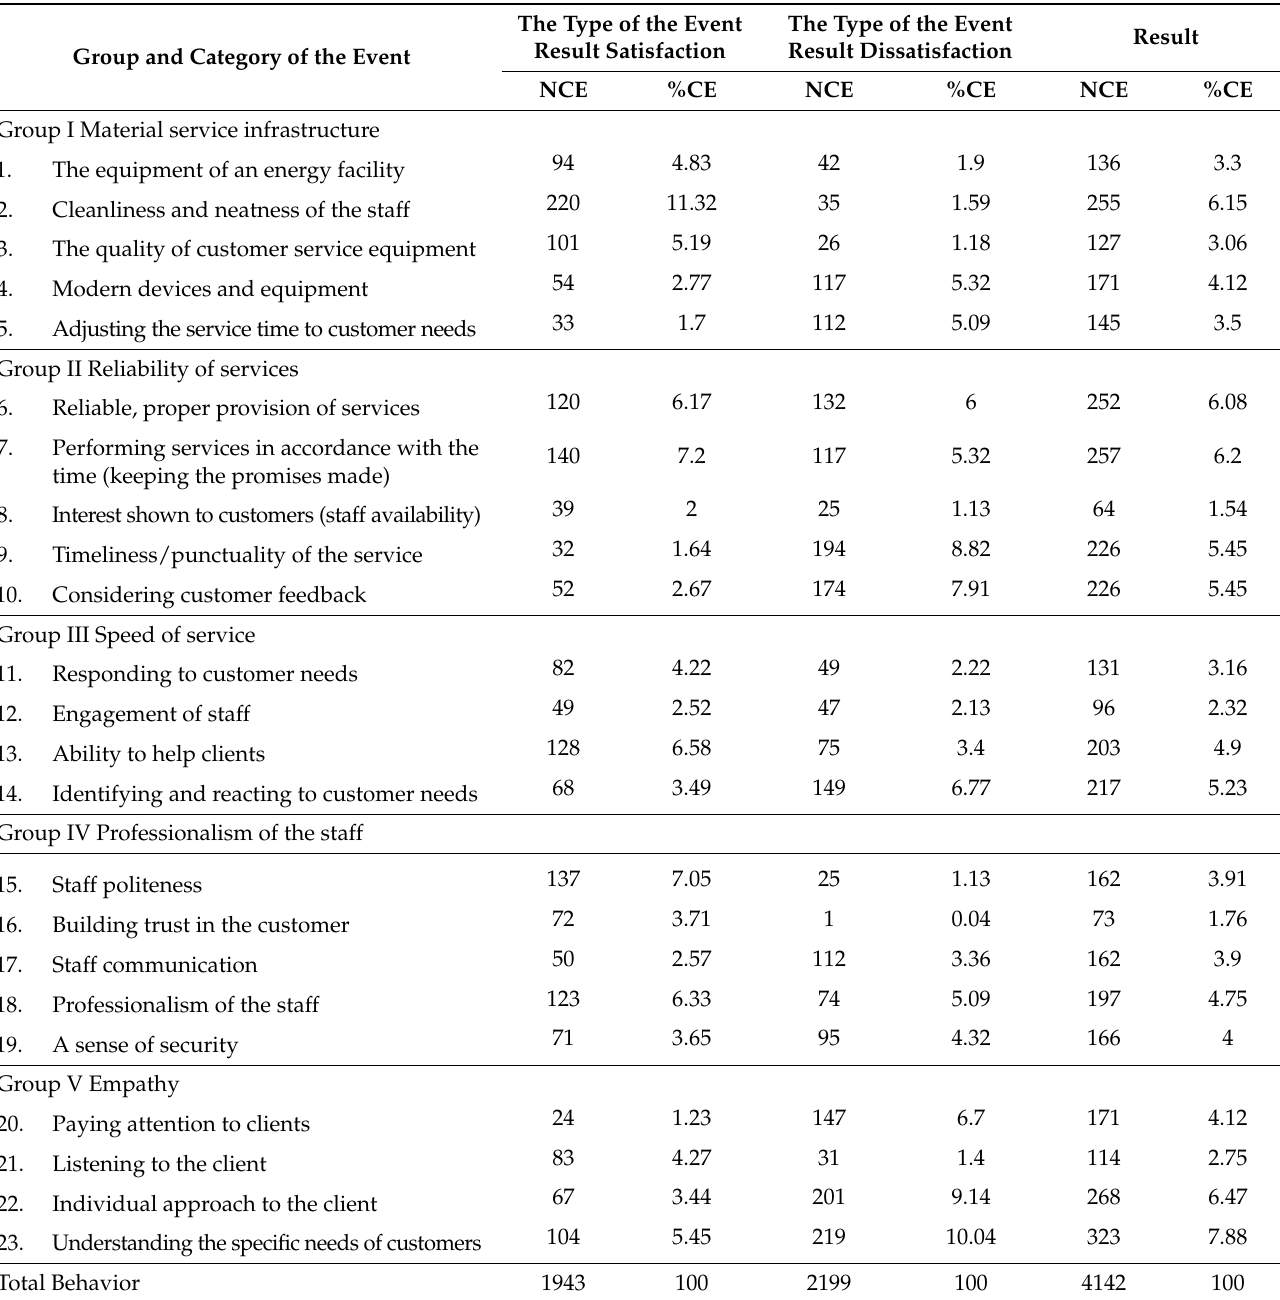
Table 3. Classification of groups and categories according to the results of events (NCE—the number of critical events, %CE—the percentage of critical